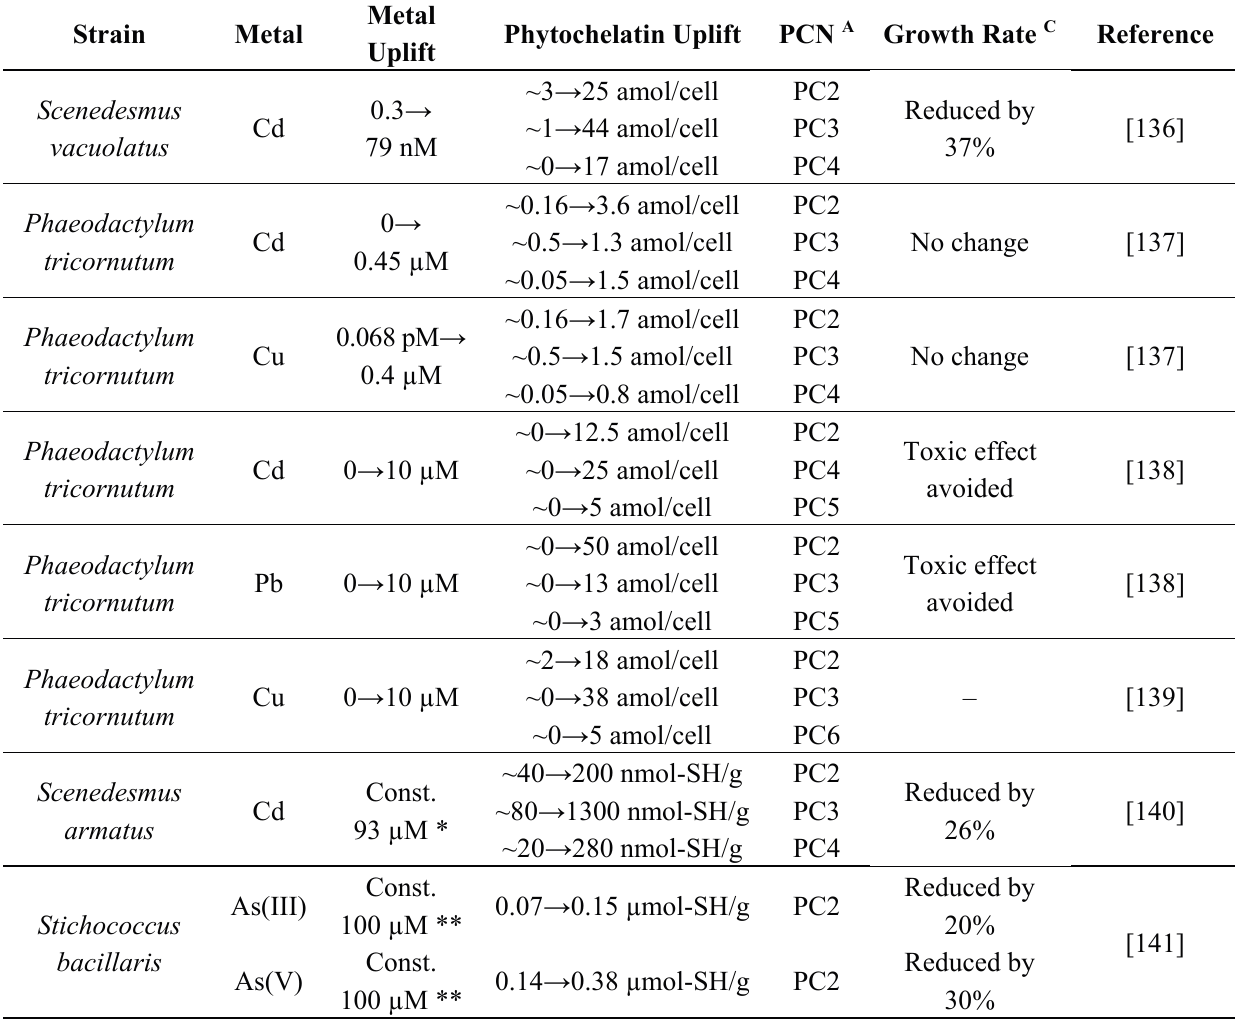
Table 3. Synthesis of phytochelatin in microalgae exposed to heavy